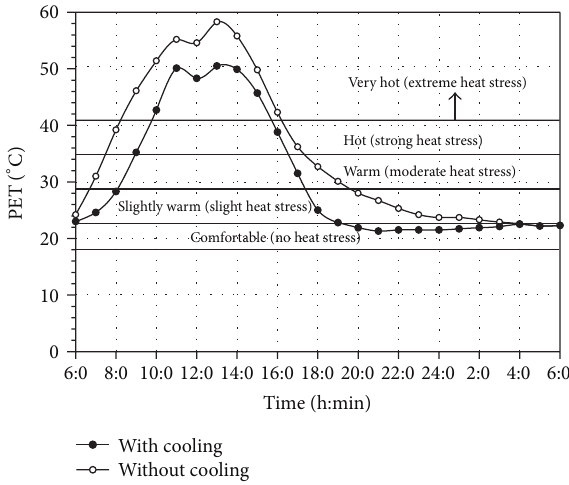
Figure 4: Time course of the wet bulb globe temperature index (WBGT) estimated in the greenhouse with and without cooling of the inside air.